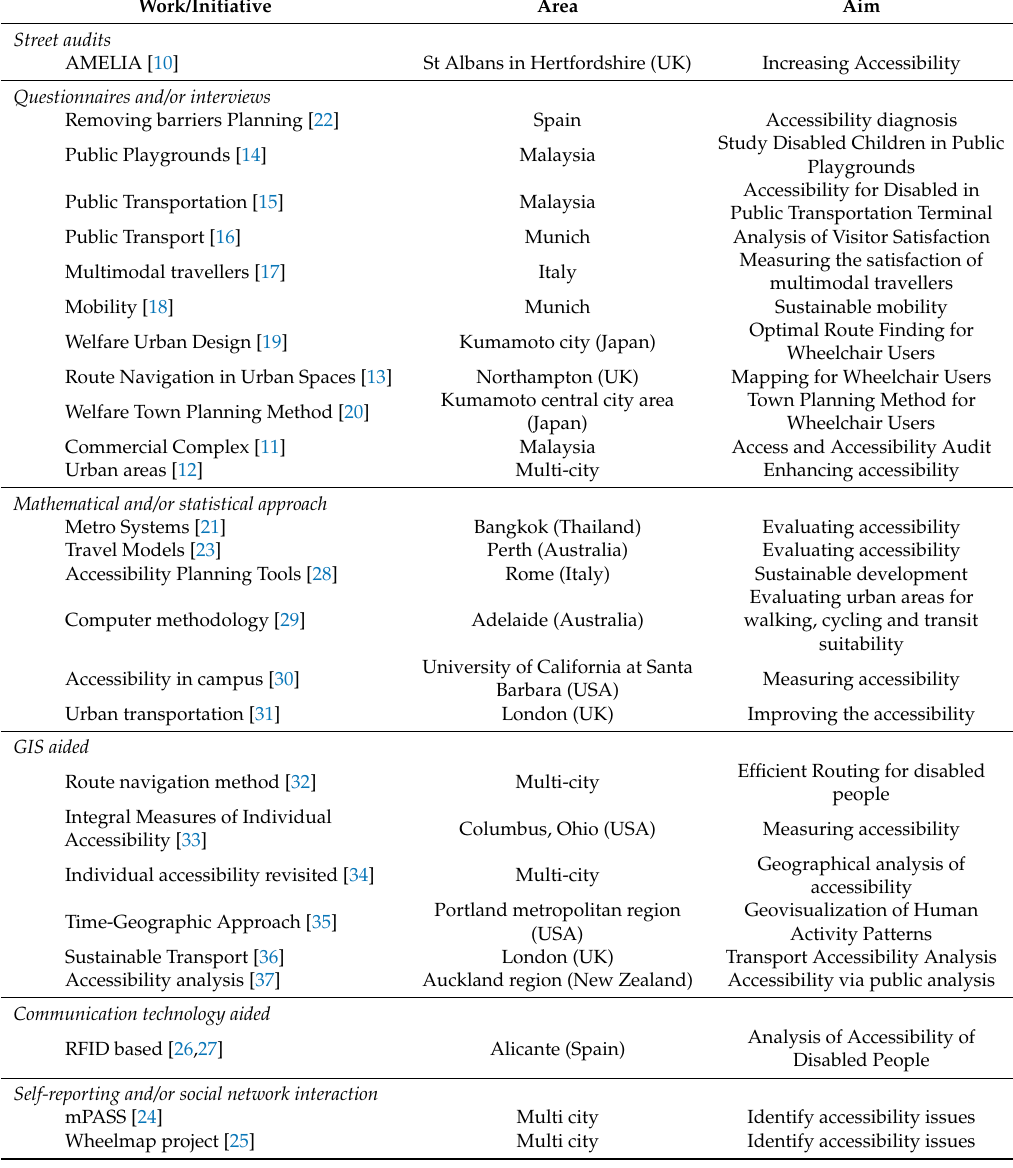
Table 1. Dynamic analysis of urban accessibility works clustered by